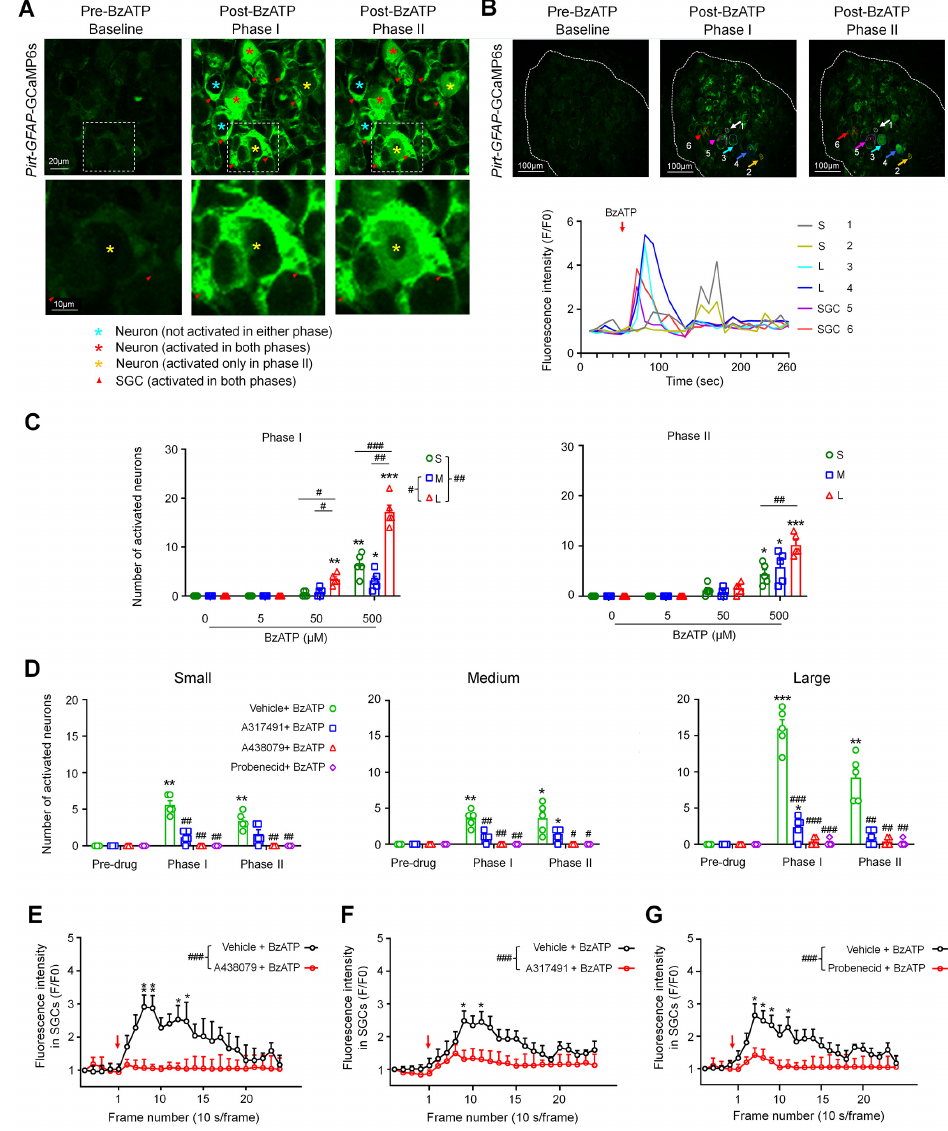
Figure 3. Pretreatment with A317491, A438079, and probenecid inhibited the activation of neurons and satellite glial cells (SGCs) by BzATP. ( A ) Upper: Representative images showing DRG neurons and SGCs after ganglionic administration of BzATP (100 µM) in Pirt : GFAP -GCaMP6s mice. Baseline (Frames (F)1–5, 10 s/frame), phase I (F6–7), and phase II post-drug (F8–26). Lower: The high-magni- fication images of the boxes outlined in the upper panel. ( B ) Upper: Examples of activated neurons (#1–4) and SGCs (#5–6) are marked with colored circles and arrows. DRG neurons were categorized by somal area as <450 µm 2 (small, S), 450–700 µm 2 (medium, M), and >700 µm 2 (large, L). Lower: Fluorescence-intensity traces ( F/F 0 ) of DRG neurons and SGCs activated by BzATP. ( C ) Number of neurons in each subpopulation activated by BzATP (5, 50, 500 µM, n = 6 mice) in phase I and phase II. Data are expressed as mean ± SEM. * p < 0.05, ** p < 0.01, *** p < 0.001 versus vehicle (0 µM); # p < 0.05, ## p < 0.01, ### p < 0.001 versus indicated group. Two-way